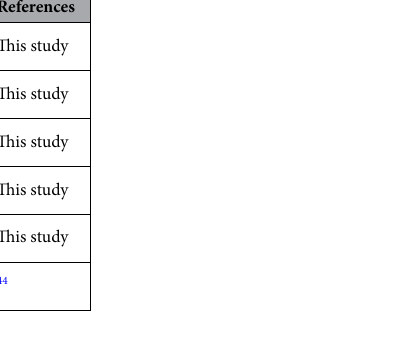
Table 2. The list of primers sequences for real-time